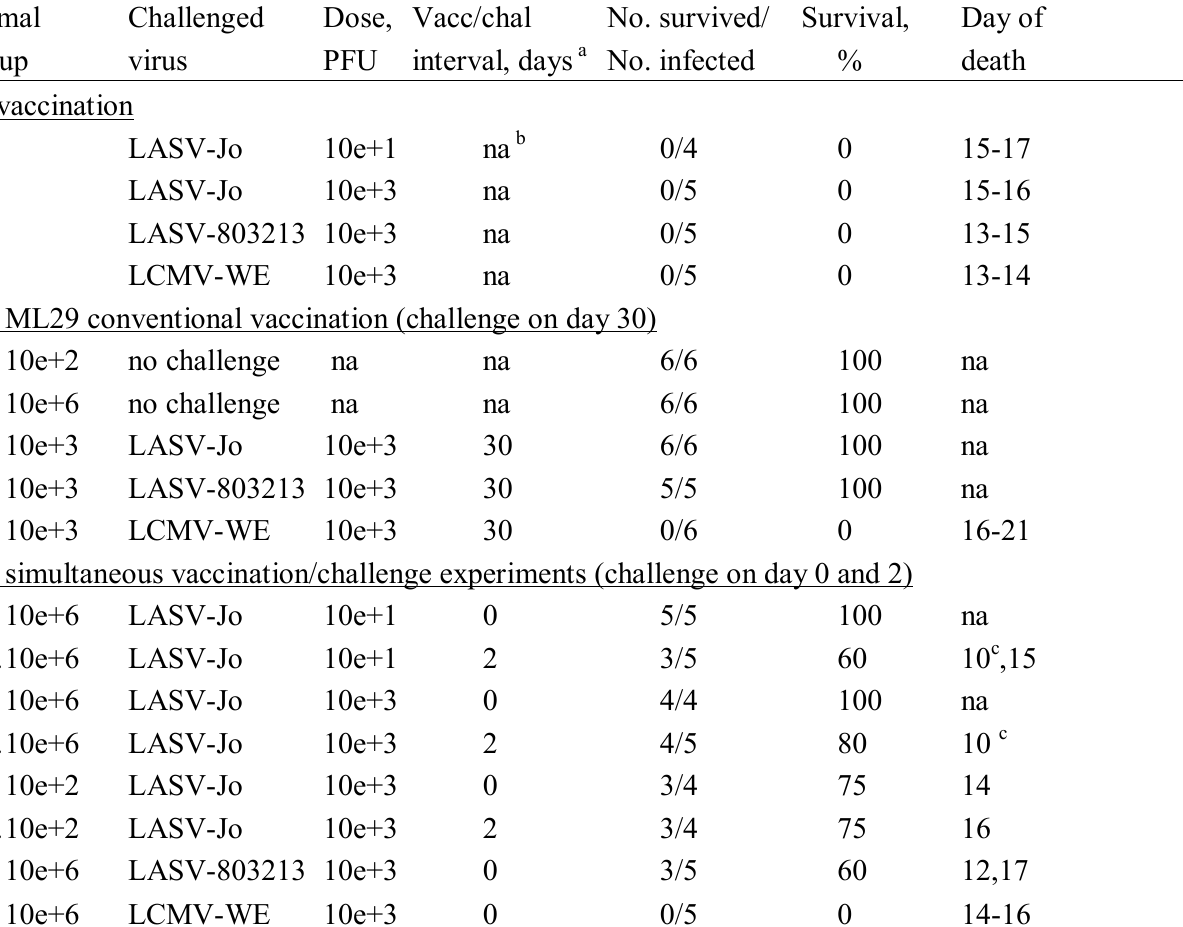
Table 2. Results of vaccination and challenge experiments in guinea pigs